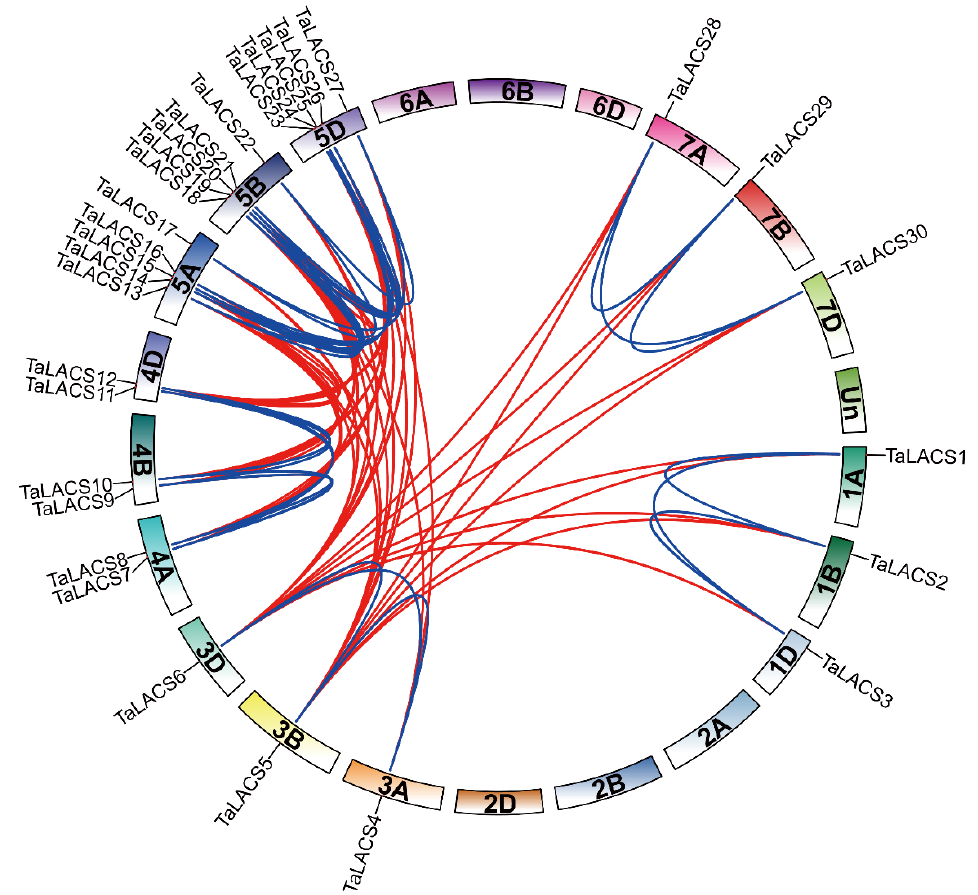
Figure 3. Synteny relationships of LACS genes in wheat. The outer circle segment represents the wheat chromosomes including “unchromosomes”. Un denotes genes with unknown physical positions. Link lines in the circle represents segmental duplication pairs between TaLACSs . The blue and red lines represent the segmental duplication pairs between the homologous and paralogous TaLACSs